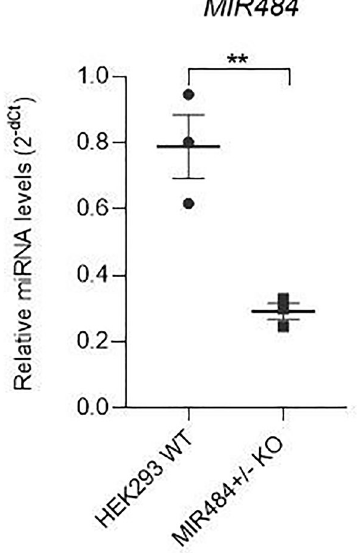
Figure 4. The difference in the relative expression of MIR484 between MIR484 +/− KO and HEK293 WT. Relative miRNA levels were standardized against RNU44 endogenous control and presented as a scatter plot of 2 −dCt values with standard errors of the mean from three independent replicates. The P value was determined using Student’s t-test, P = 0.007. ** denotes a significant difference at P <